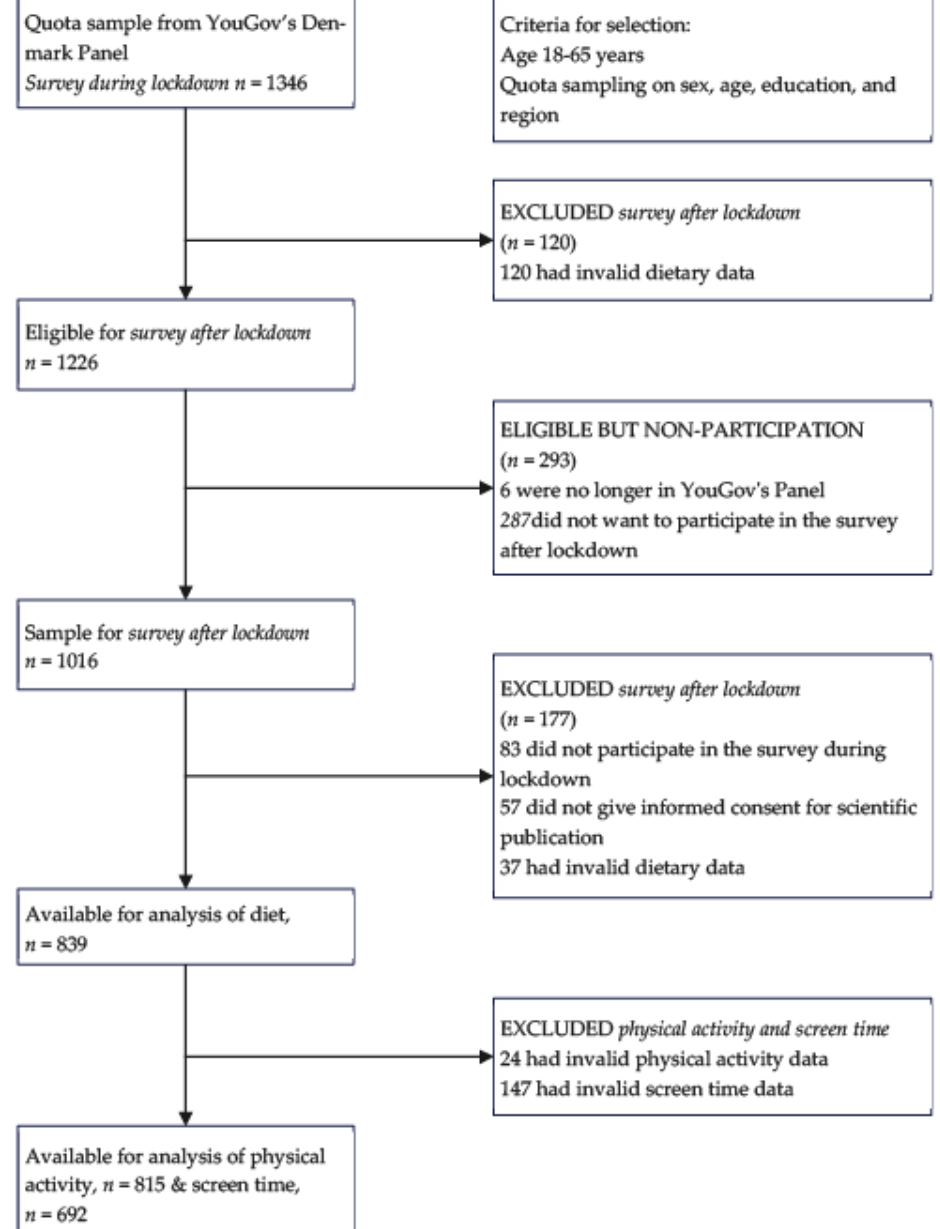
Figure 1. Participant flow chart of the current study.